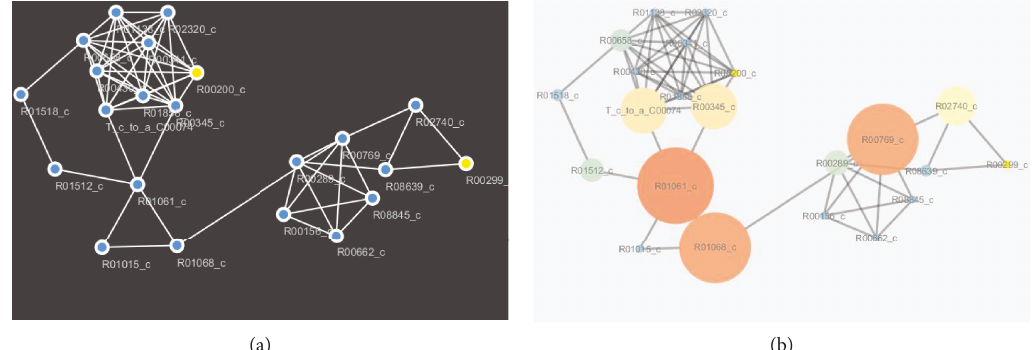
Figure 6: (a) Predicted glycolysis pathway. (b) Predicted essential glycolysis pathway.